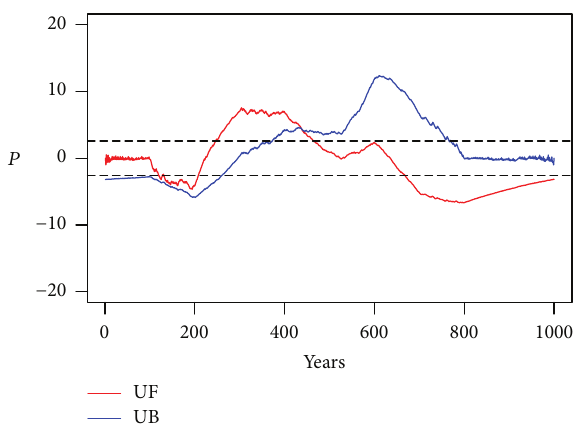
Figure 3: Abrupt changes detected in the artificial time series by the Mann-Kendall test.